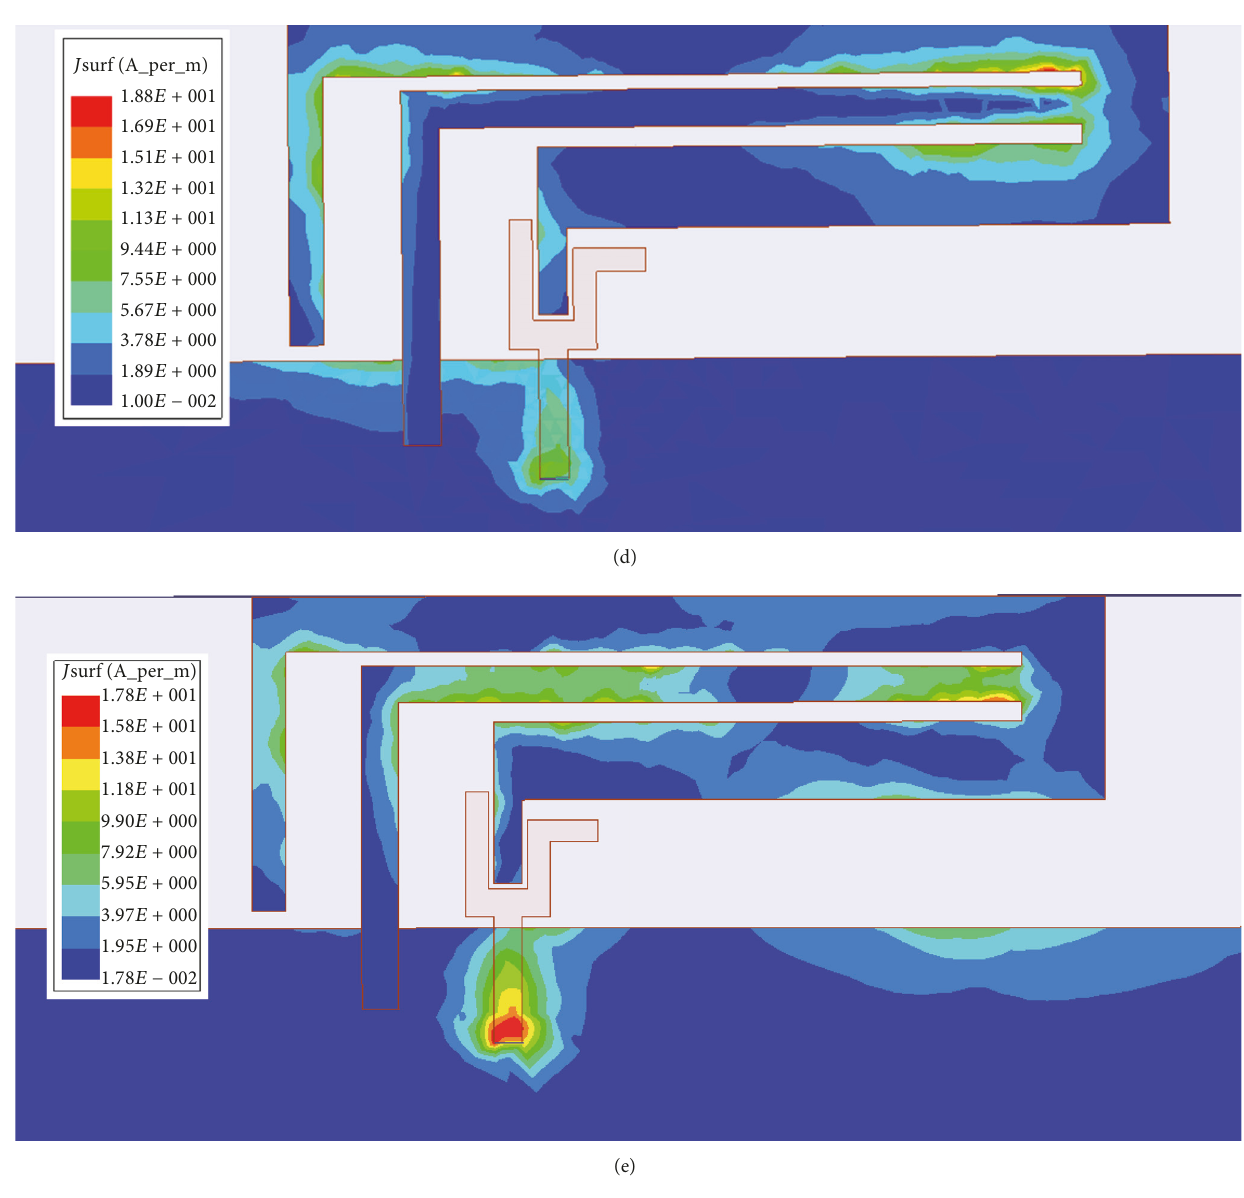
Figure 4: Simulated current distributions on the radiating metal portion and the ground plane at (a) 915 MHz; (b) 1575 MHz; (c) 2450 MHz; (d) 3300 MHz; and (e) 5875